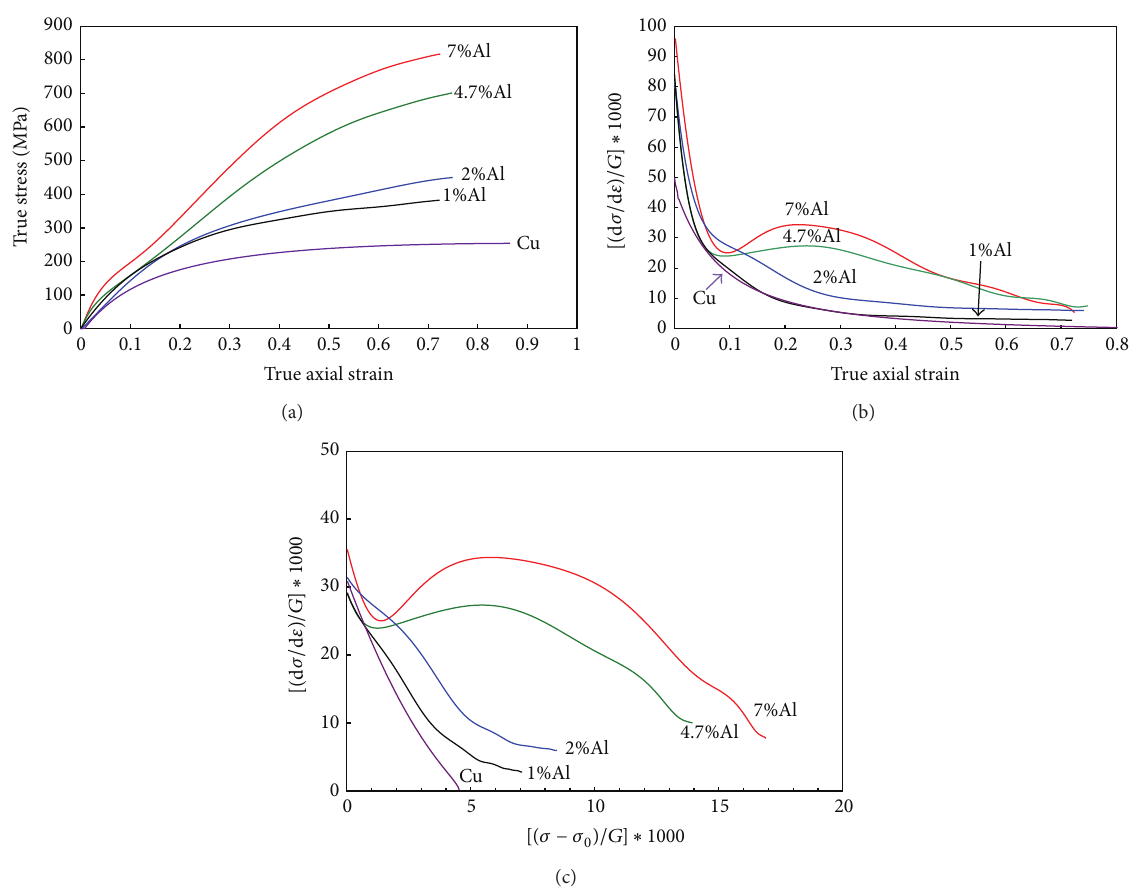
Figure 4: (a) True stress-true strain response for all materials with an average grain size of 250 𝜇 m, tested in plane strain compression. Normalized strain hardening rate versus true strain in (b) and versus normalized stress parameter in (c) for all materials displayed in part